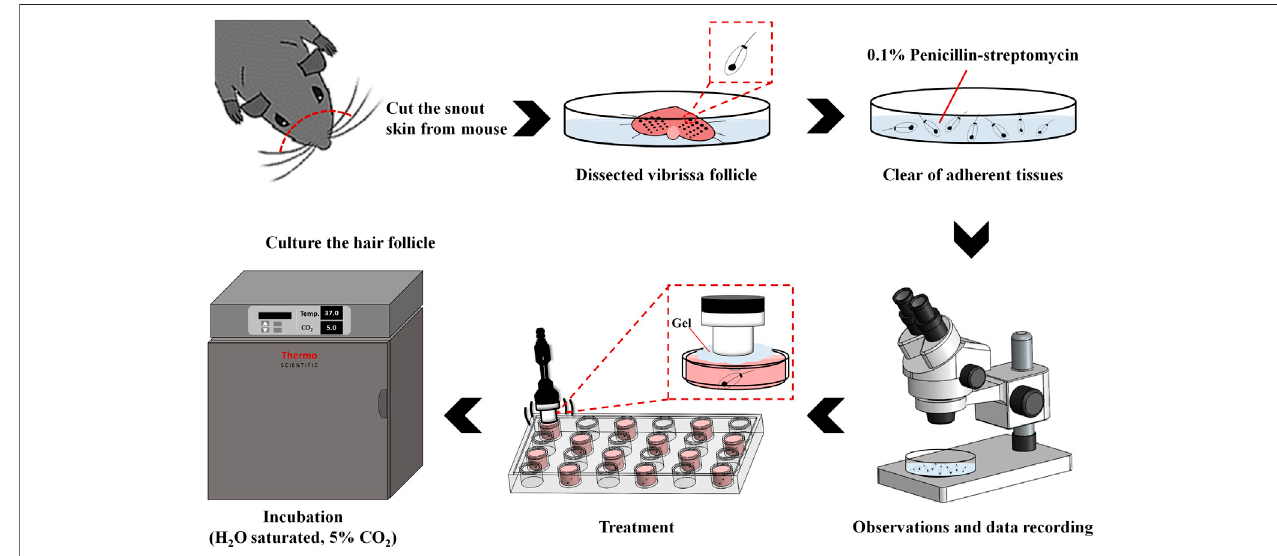
FIGURE 2 | Schematic of the process of culturing in vitro murine vibrissae in serum-free medium.